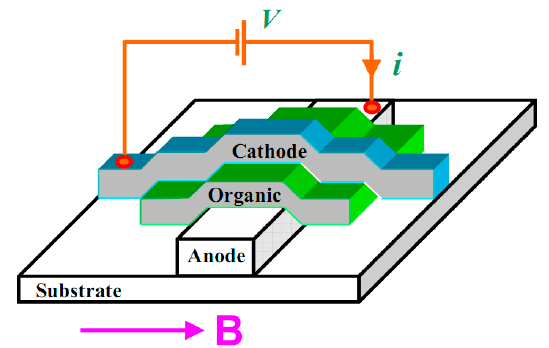
Figure 9. Schematic diagram of the experimental device corresponding to the magnetic field effect of organic devices by Mermer et al. [11] with the permission of Physical Review B.